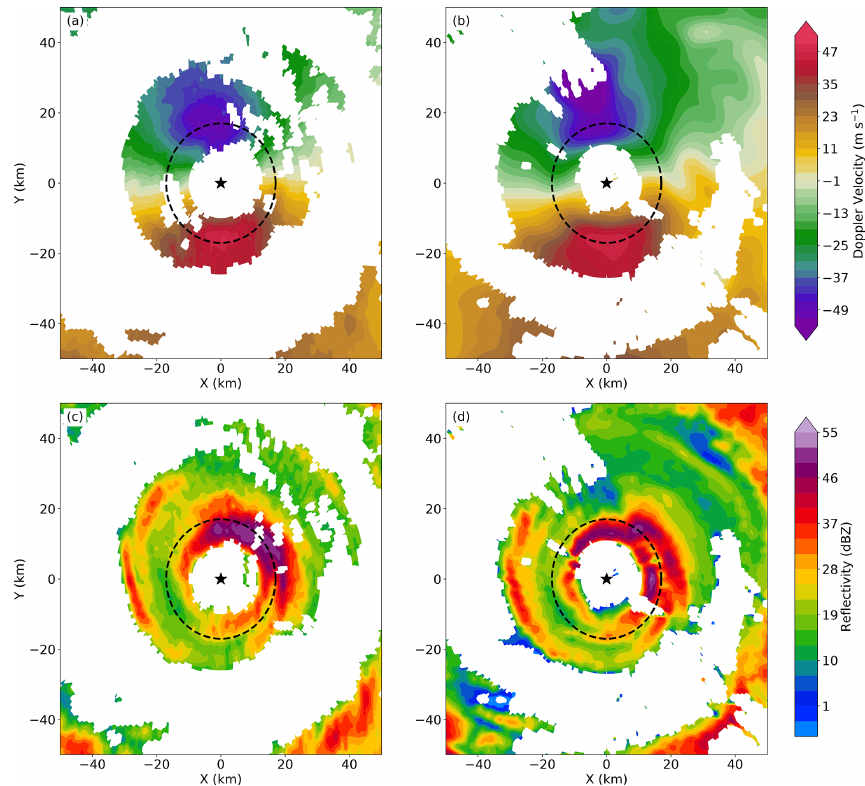
Figure 3. Doppler velocity at 4km constant altitude (a) observed by the KAMX radar at 19:21UTC and (b) resampled from the dual-Doppler analysis synthesized from 18:55 to 19:40UTC. Reflectivity at 4km altitude (c) observed by the KAMX radar and (d) derived from the dual- Doppler analysis. The timing of panels (c) and (d) are the same as panels (a) and (b) , respectively. The black star denotes the TC center, and the dashed circle denotes the radius of maximum wind of 18km. Table 3. The averaged root-mean-squared error of the V T C 0 and the integrated perturbation pressure deficit retrieved from different methods described in Fig. 4 from the four flight passes and single-Doppler radar observations. The errors are calculated from r = 10 to 70km on z = 4km. RMSE P-3 dual Doppler NEXRAD single Doppler Optimal Optimal but no Original Improved Original Improved storm motion GVTD GVTD GVTD GVTD 1.49 Integrated perturbation pressure deficit